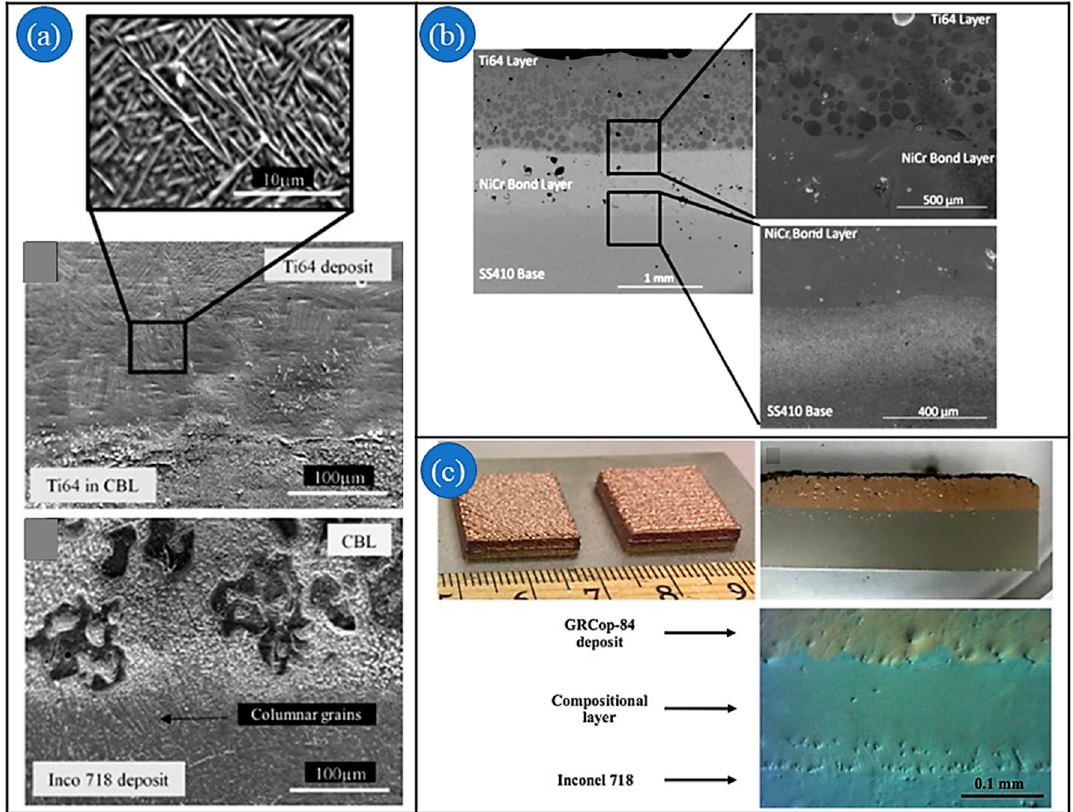
Figure 2. ( a ) SEM images of the Interface of the as-built bimetallic structure of Ti-6Al-4V and In718 [63], ( b ) Cross-Sectional SEM image of Ti-6Al-4V bonded to SS410 processed using LENS ™ [64], ( c ) as-fabricated bimetallic structure of In 718 and copper [65]. Table 2. Summary of some applications of DED as repair and dedicated systems for repairing.